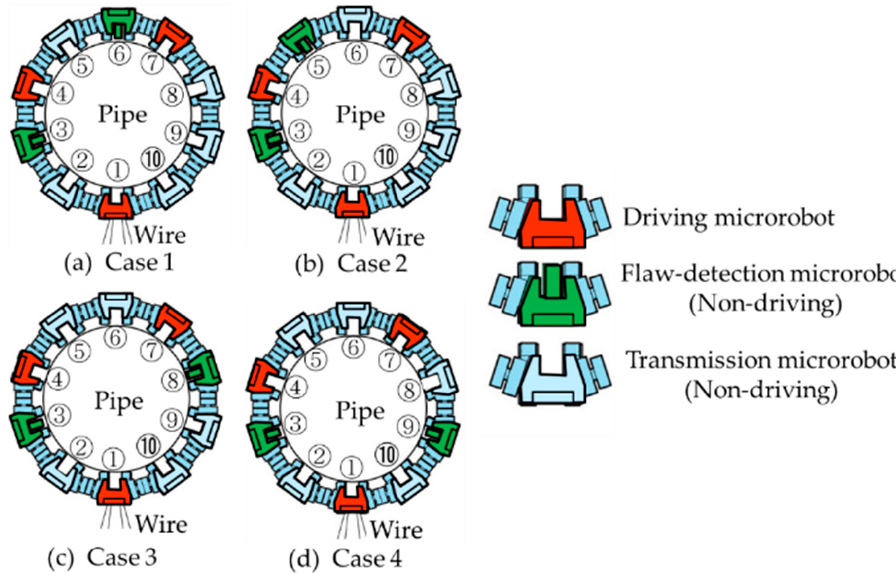
Figure 13. Ten microrobots were arranged around a pipe. There were three types of microrobots: a driving microrobot that has driving devices, a flaw-detection microrobot that has a flaw-detection sensor but does not have driving devices, and a transmission microrobot that transmits power and sensor signals but does not have driving devices. Four cases are shown, in which the positions of the two flaw-detection microrobots are different. In case 1 and case 2, the flaw-detection microrobots were placed between the driving microrobots ① and ④, and ④ and ⑦ . In case 1, the flaw-detection microrobots were placed on the right side of the driving microrobots ④ and ⑦ . In case 2, the flaw-detection microrobots were placed on both sides of the driving microrobot ④ . In case 3 and case 4, the flaw-detection microrobots were placed between the driving microrobots ① and ④, and ① and ⑦ . The difference between cases 3 and 4 was the presence or absence of the driving microrobot next to the flaw-detection microrobot between the driving microrobots ① and ⑦ .